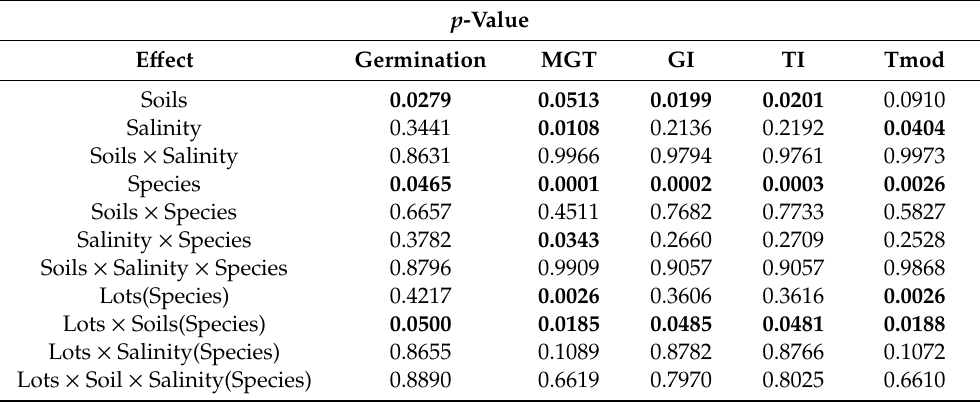
Table 3. Statistically significance di ff erences at ( α ≤ 0.05) for fixed factors soils, salinity, species, lots, and their interactions for five germination response variables; germination %, MGT, GI, and TI and Tmod for alfalfa, triticale and quinoa. Abbreviations: MGT, mean germination time; GI,